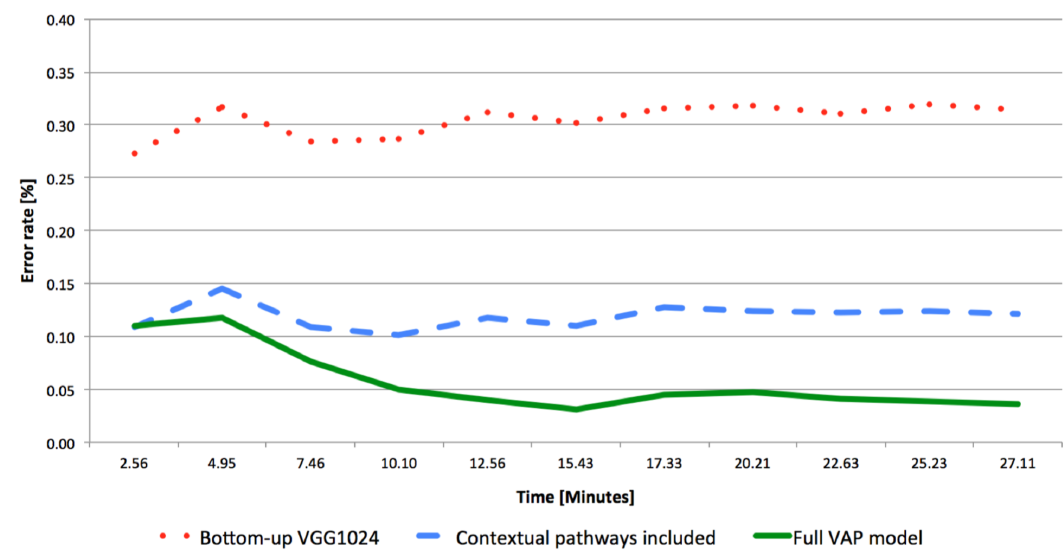
Figure 10. Performance on video sources of the VAP model with the VGG1024 faster RCNN as the bottom-up classifier.